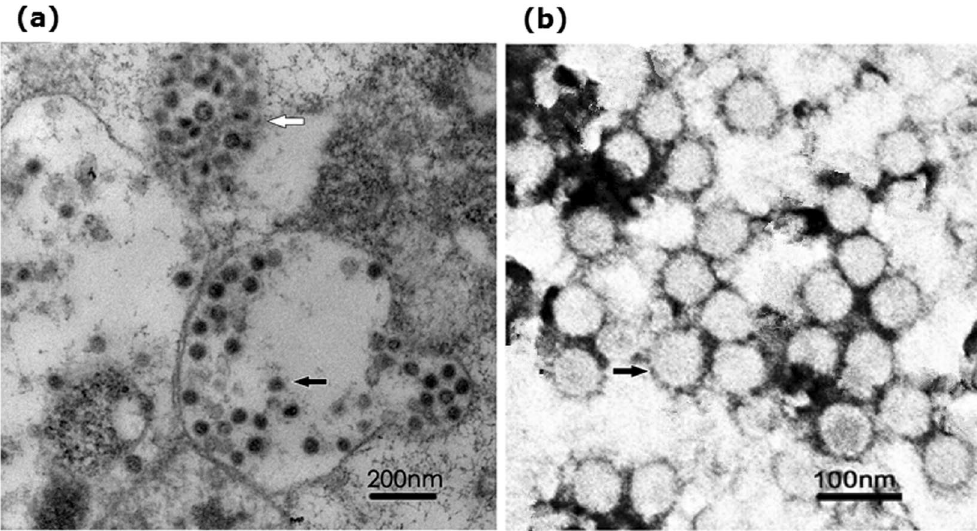
Figure 1. Ultrastructural characteristics of NDiV-SZ11706Z. ( a ) Ultrathin sections of NDiV in a cytoplasmic vacuole (black arrow) and a higher magnification of vesicles containing numerous virions (white arrow). ( b ) Electron micrograph of negatively stained NDiV